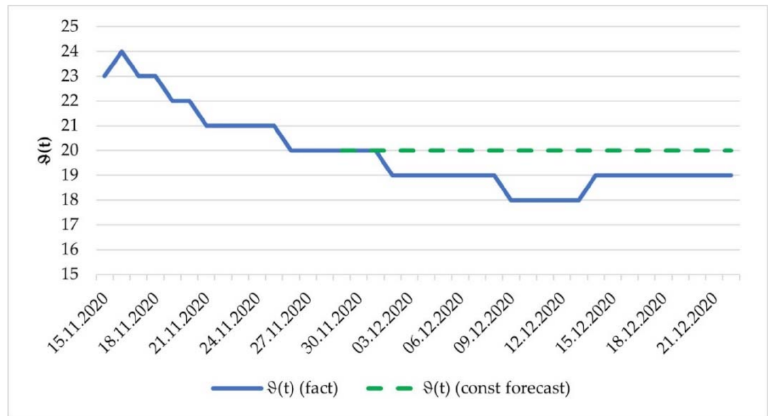
Figure 6. Actual and modeled values of the dynamic balance characteristic ϑ ( t ) from 15 November